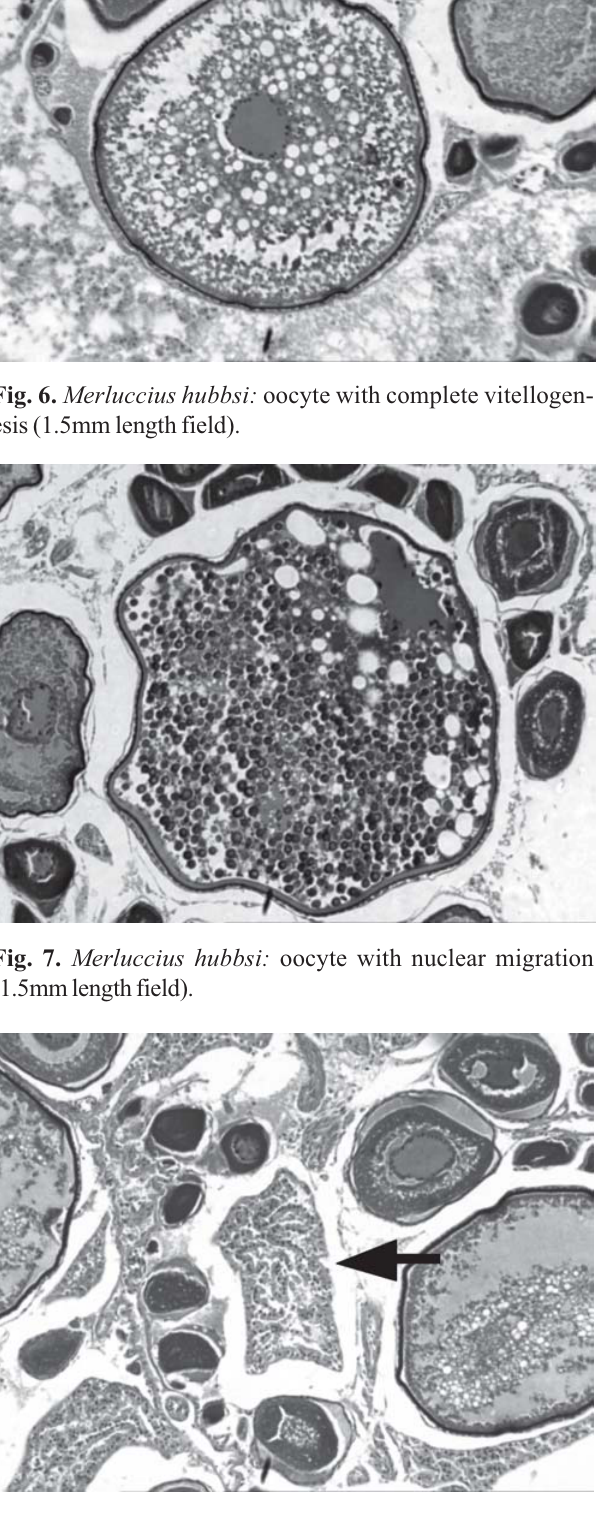
Fig. 8. Merluccius hubbsi: postovulatory follicle (arrow) (1.5mm length field).